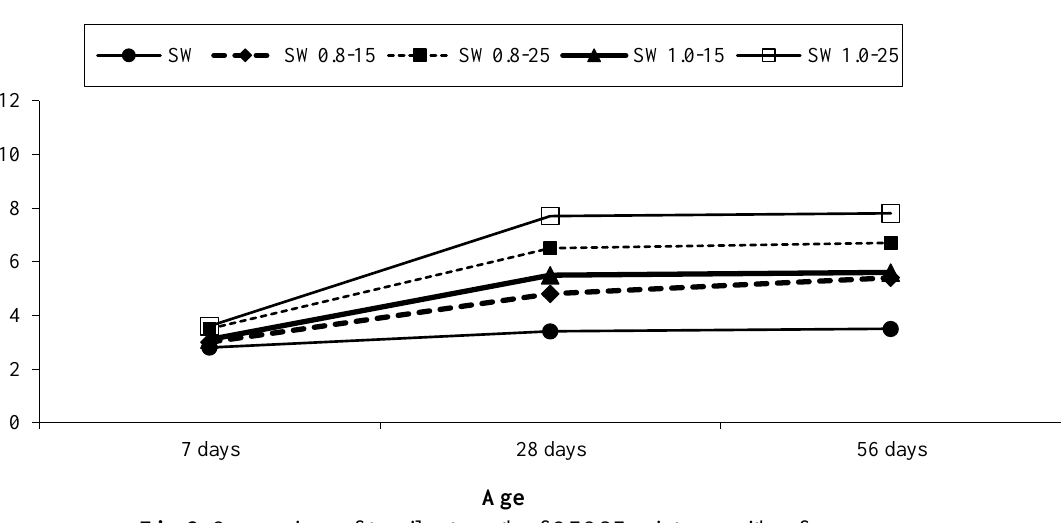
Fig. 2. Comparison of tensile strength of CFCSF mixtures with reference